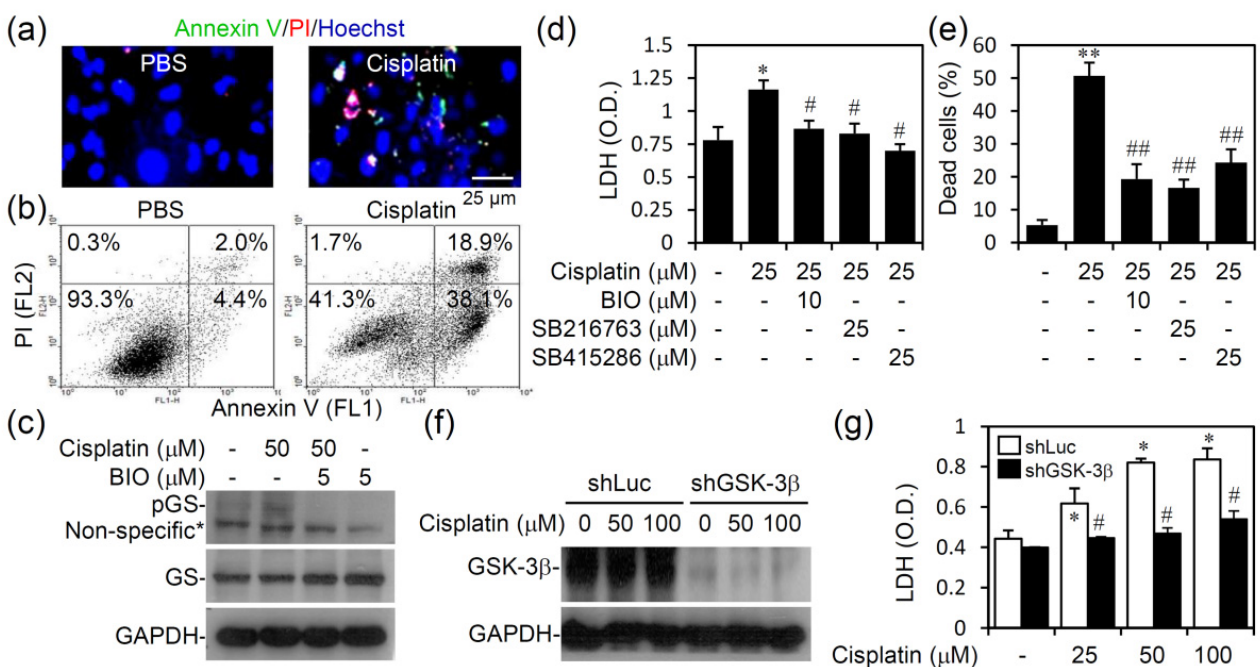
Figure 6. Cisplatin treatment causes GSK-3 β activation in vitro followed by cell death. HK-2 cells were treated with cisplatin for 24 h in the absence or presence of a 0.5 h pretreatment with the GSK-3 inhibitor BIO. ( a ) Fluorescent image of Annexin V/PI/Hoechst 33258 staining for detecting apoptotic or necrotic cells. ( b ) Flow cytometric analysis of Annexin V/PI staining for detecting apoptotic or necrotic cells. ( c ) Representative Western blotting showed the expression of phospho-GS Ser641 and GS. GAPDH was used as an internal control. Cisplatin-stimulated HK-2 cells with or without pretreatment with the GSK-3 inhibitors BIO, SB216763, and SB415286 were assessed for ( d ) cytotoxicity by determining LDH release and for ( e ) apoptotic or necrotic cells by Annexin V/PI staining. ( f ) GSK-3 β expression in shLuc- or shGSK-3 β -transfected HK-2 cells. ( g ) The LDH activity assay detected cytotoxicity. For Western blotting, a representative data set obtained from repeated experiments is shown. Data are the mean ± SD of triplicate cultures. O.D., optical density. * p < 0.05 and ** p < 0.01 compared with PBS. # p < 0.05 and ## p < 0.01 compared with cisplatin-treated and shGSK-3 β -transfected cells.